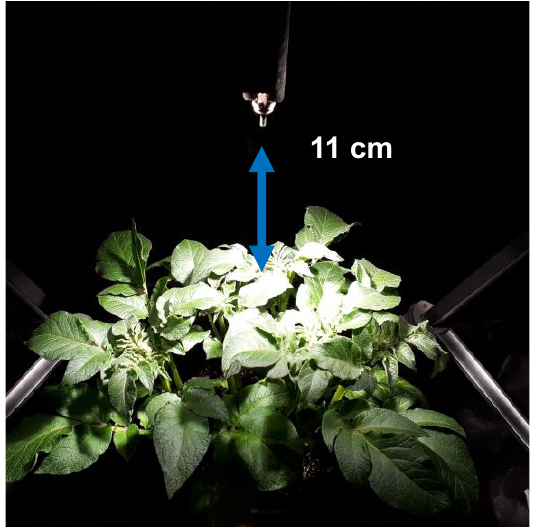
Figure 1. Illustrative scheme for data acquisition scenario at the canopy level.